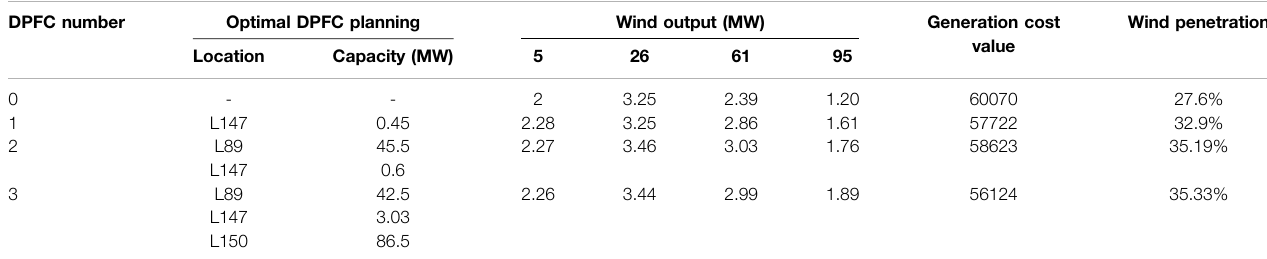
TABLE 2 | Solution of optimal location allocations of DPFC. DPFC